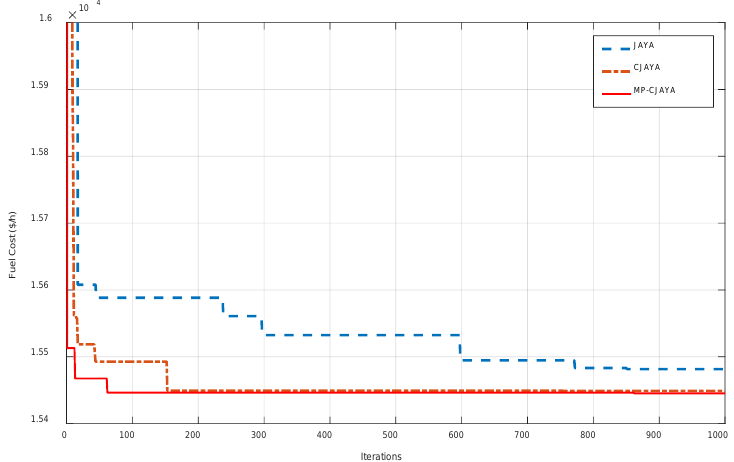
P = 1263 MW). P = 1263 MW). D D